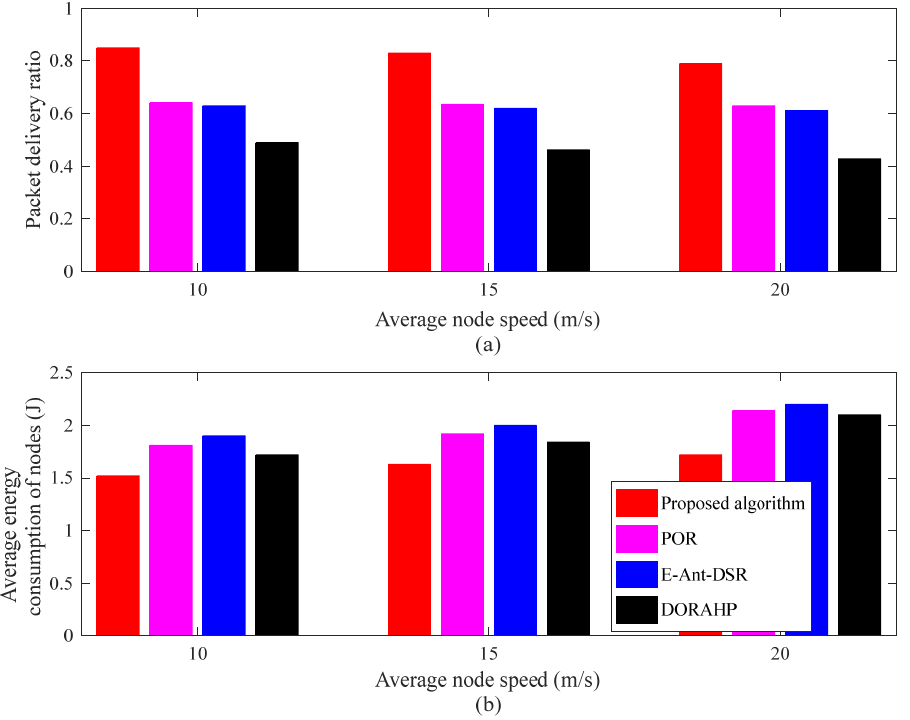
Figure 6. Comparison with variable node moving speed. ( a ) Packet delivery ratio. ( b ) Average energy consumption of nodes.